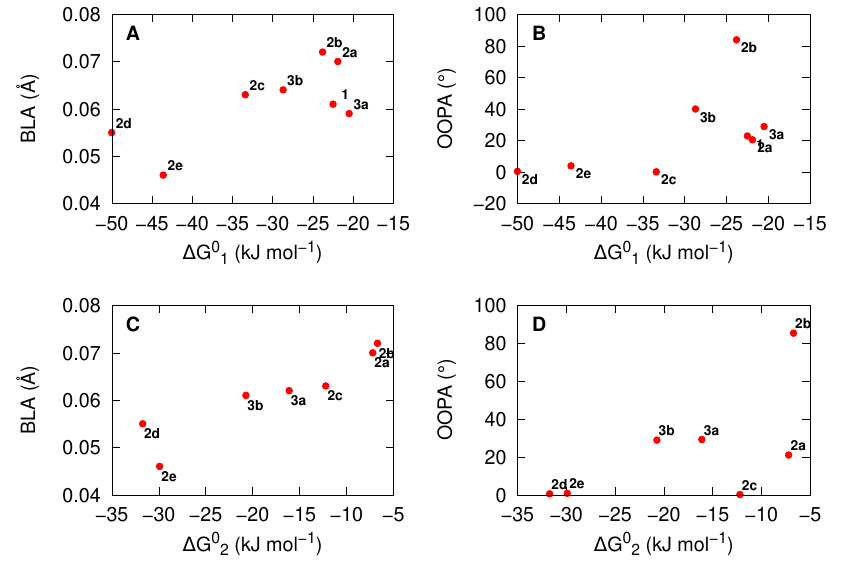
Figure 5. Correlation between the BLA (Å, panels A and C ) and OOPA (°, panels B and D ) of the open moiety with the corresponding Gibbs free energy along the first ( ∆ G 0 B ) and second ( ∆ G 0 , kJmol − 1 , panels C and D ) protonation reactions with TFA. The calculations 2 used the ω B97X-D/6-311G(d)/IEF-PCM (acetonitrile) level of theory for the BOXs and the ω B97X- D/6-311+G(d)/IEF-PCM (acetonitrile) level of theory for the